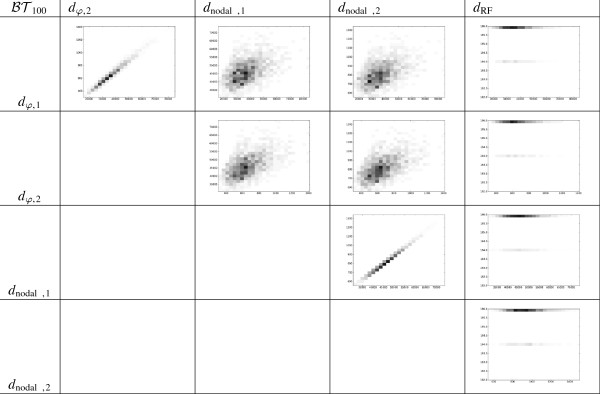
2D-histograms showing the relationship between different distances onBT100.